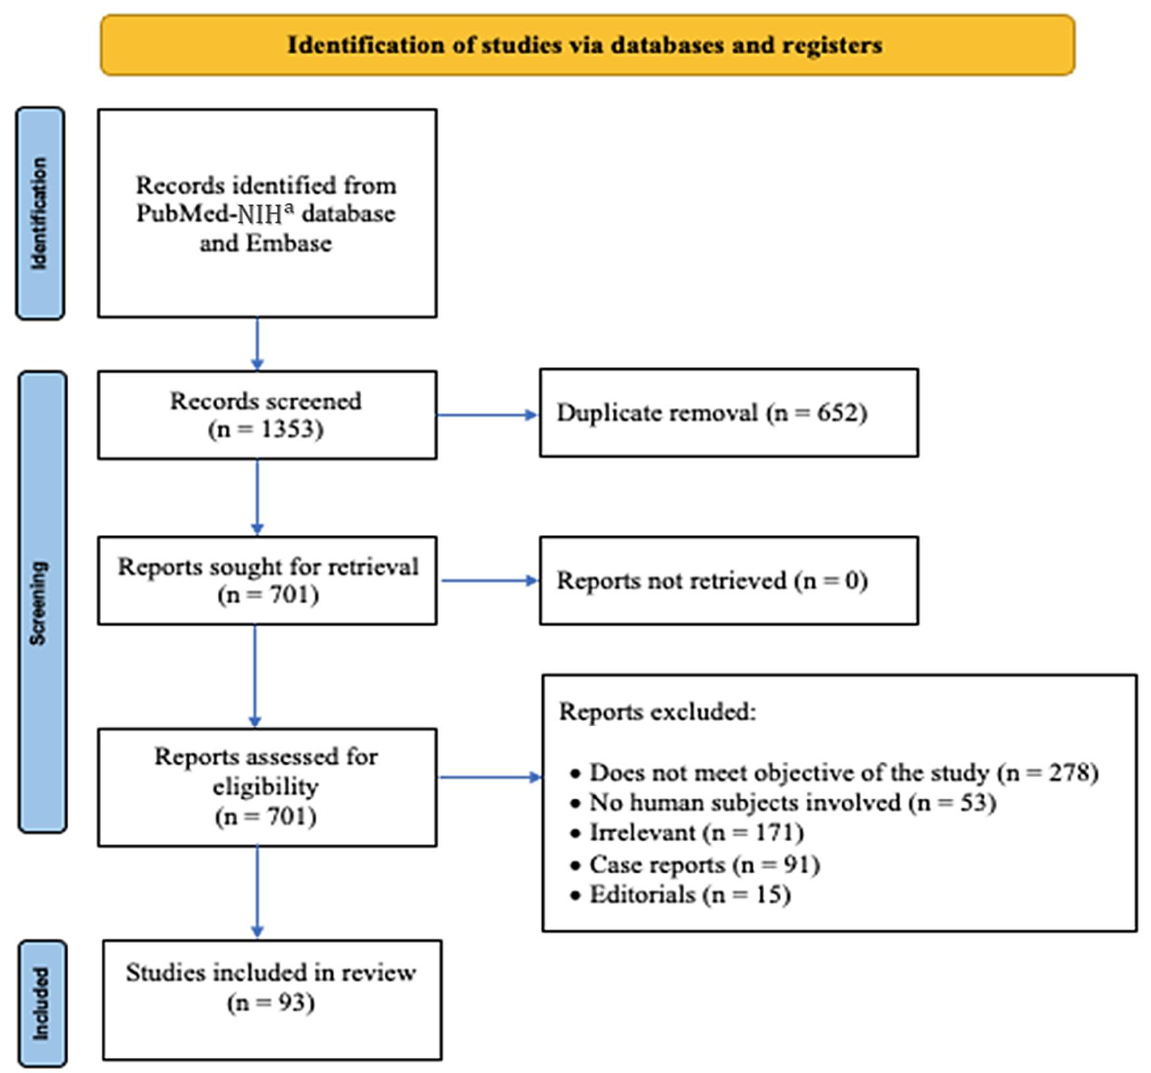
Figure 1. PRISMA flow diagram. PRISMA: Preferred Reporting Items for Systematic Reviews and Meta-Analyses. a National Institutes of Health.